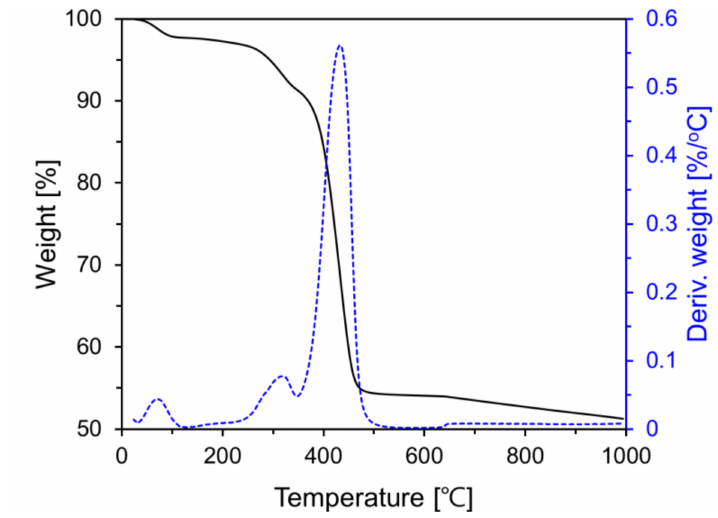
Figure 2. TG/DTG measurements of CNT.